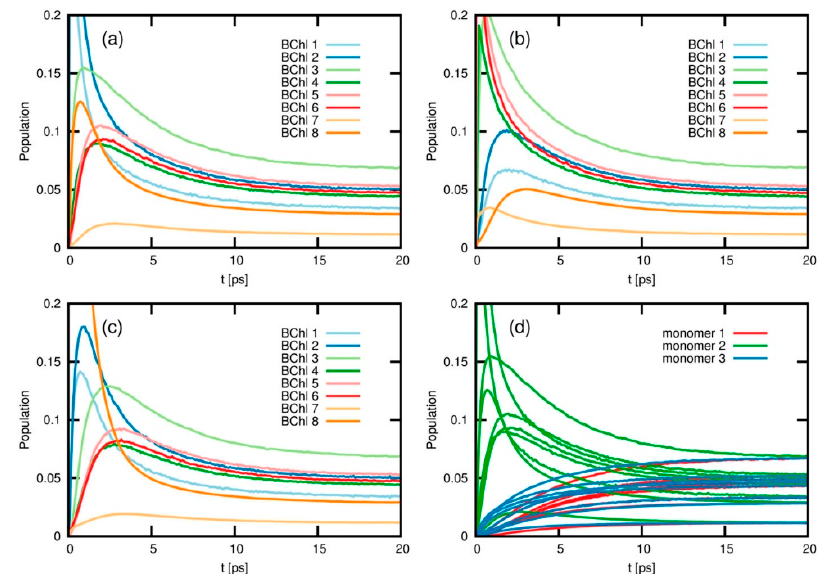
Figure 8. Long time electronic energy transfer (EET) dynamics in the 24-state model of the FMO trimer complex ( T = 300 K) for initial excitation of BChl 1 ( a ), BChl 6 ( b ), and BChl 8 ( c ), respectively. The population of all 24 states is shown for initial excitation of BChl 1 of FMO monomer 2 ( d ); k eff = 8, = 10 − 7 . Reproduced from [86] with permission from AIP, 2017.